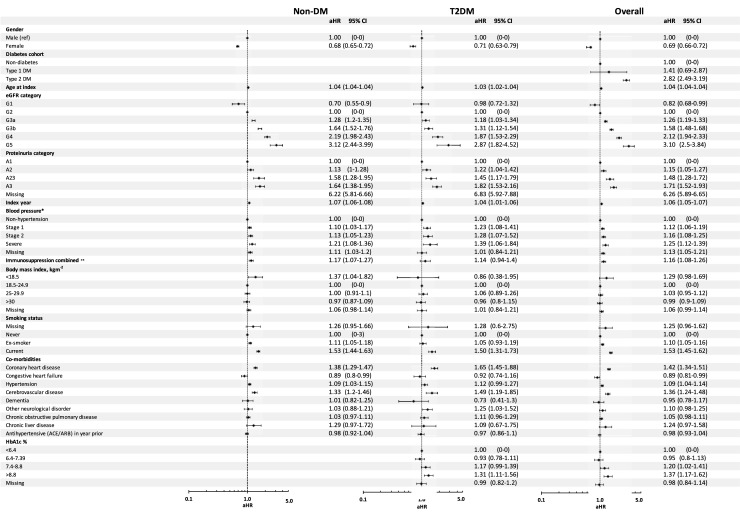
Adjusted hazard ratios for first major adverse cardiovascular event in type 2 diabetes, non-diabetes, and overall (combined types 1 and 2 diabetes and non-diabetes) cohorts.* Non-hypertension = systolic < 140, or diastolic < 90; stage 1 = 140 ≤ systolic blood pressure < 160, or 90 ≤ diastolic < 100; stage 2 = 160 ≤ systolic < 180, or 100 ≤ diastolic < 110; severe = systolic ≥ 180, or diastolic ≥ 110 (units = mmHg). ** Patient has a prior record of immunosuppressive disease or was prescribed an immunosuppressive therapy in the year prior to baseline. aHR, adjusted hazard ratio. CI, confidence interval. DM, diabetes. Non-DM, non-diabetes. T2DM, type 2 diabetes. ACE, angiotensin-converting enzyme inhibitor. ARB, angiotensin II receptor antagonist. HbA1c, glycosylated haemoglobin.